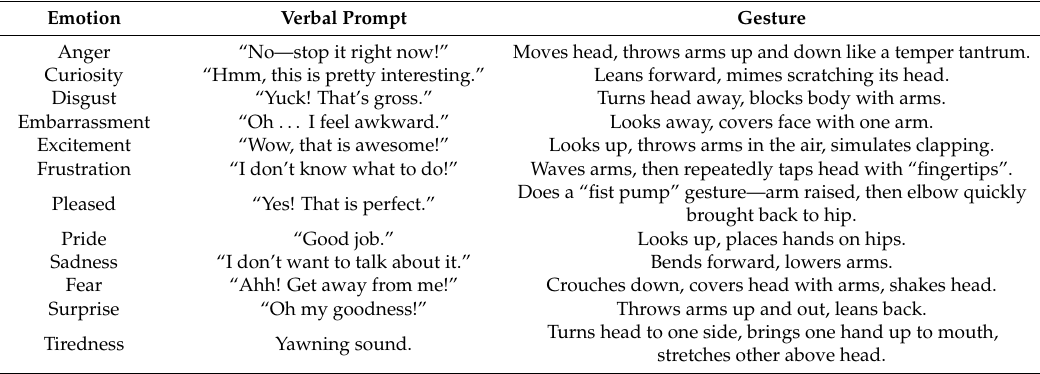
Table A1. OP2’s emotion primitives, broken down into verbal and physical descriptions.